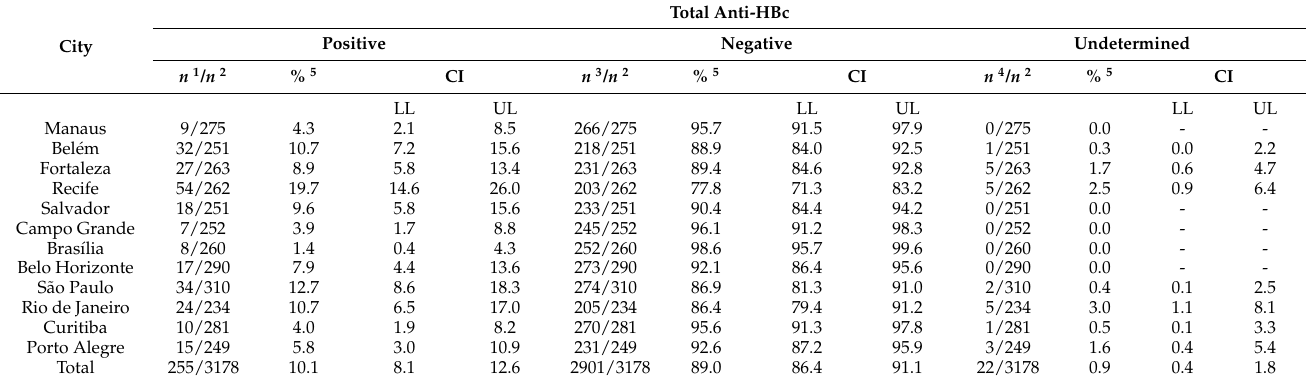
Table 2. Prevalence of total anti-HBc positive among 3178 MSM * according to studied city, Brazil,